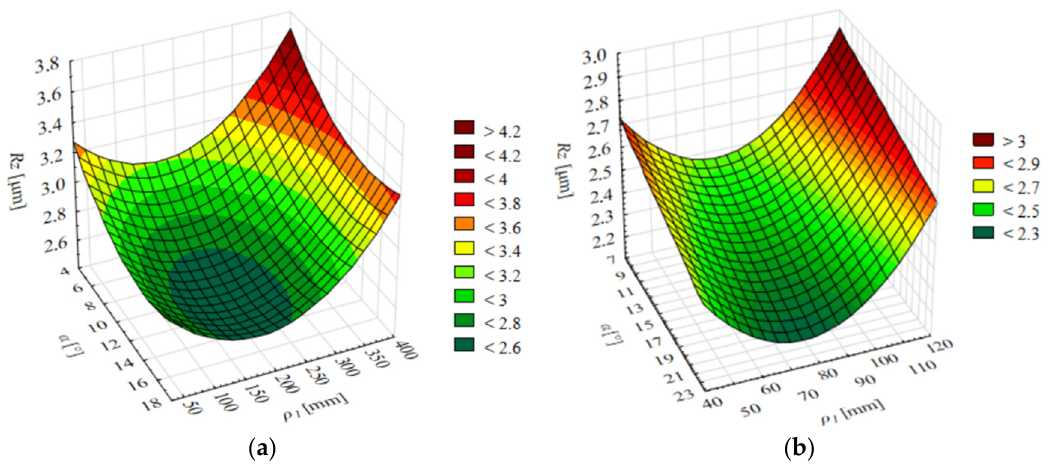
Figure 15. Influence of the lead angle α and radius of curvature ρ 1 on the Rz roughness parameter of the convex ( a ) and concave ( b ) surface.